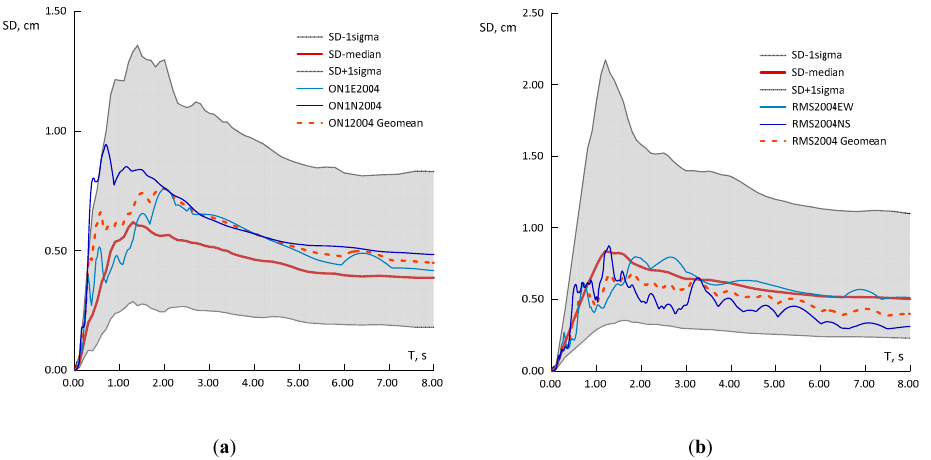
Figure 12. Predicted and computed displacement spectra for 27 October 2004 M W = 6.0 earthquake ( a ) Onesti station, type B soil; ( b ) Ramnicu Sarat station, type C soil.